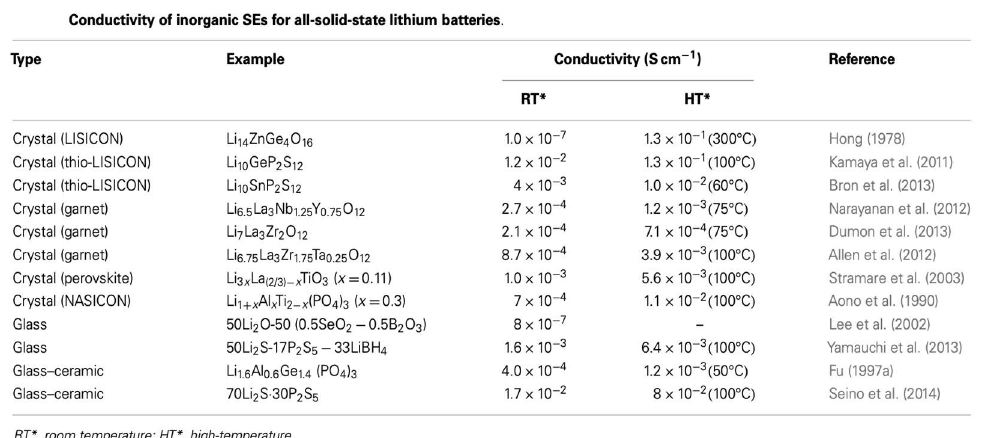
Figure 1. Various types of solid electrolytes and reported conductivities. Courtesy of Cao et al. [2] .